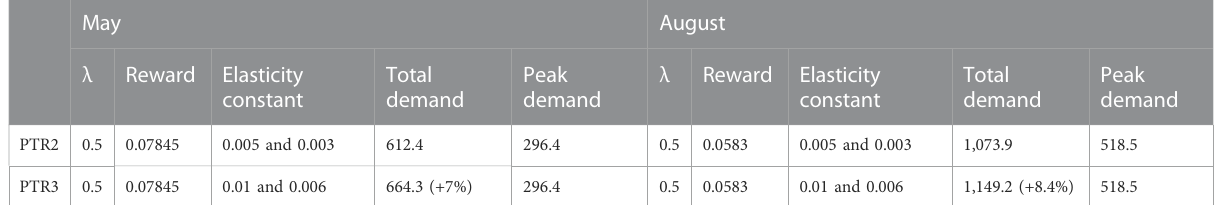
TABLE 11 Doubling of the elasticity constant